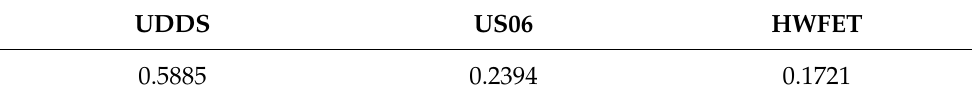
Table 3. Relative similarities between EPA dynamometer drive cycles and the data drive